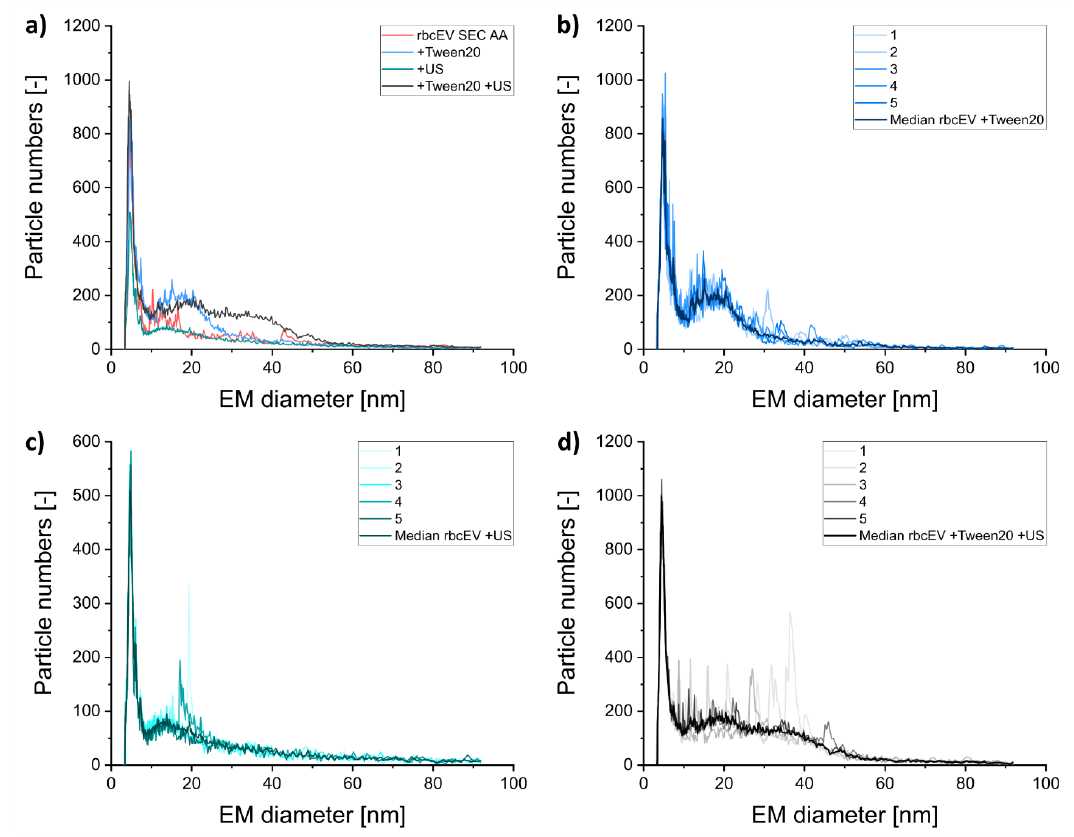
Figure 6. Relation of nES GEMMA spectra of rbcEV + SEC and the impact of different treatments ( a ) on the EV constitution and dry particle size diameter. The repeatability of the measurements for the treatments with Tween 20 ( b ), ultrasonication ( c ), and the combination ( d ) display the vesicle integrity.